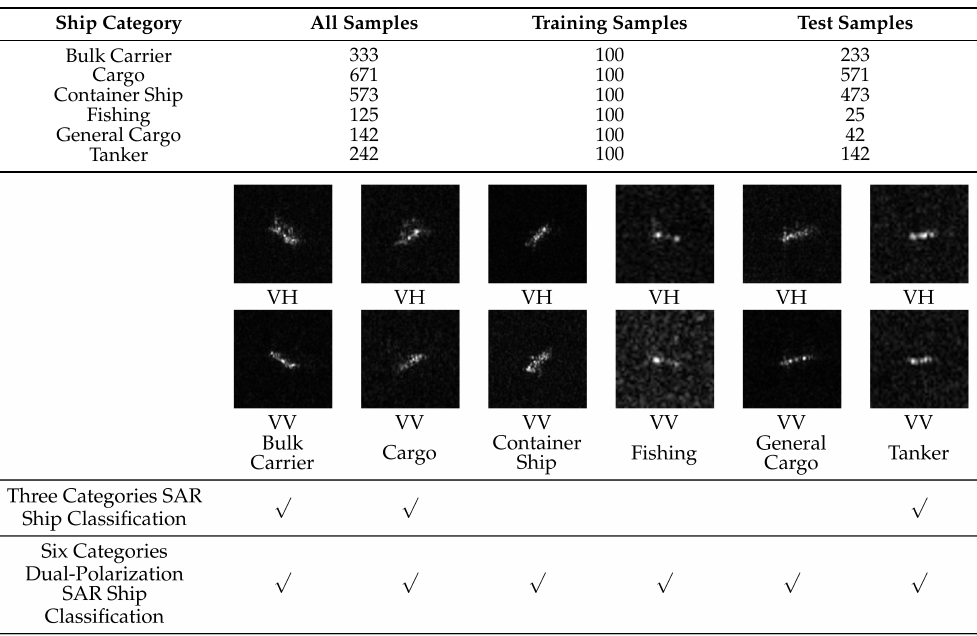
Table 4. The sample numbers of each category in the six categories SAR Dual-Polarization ship classification.